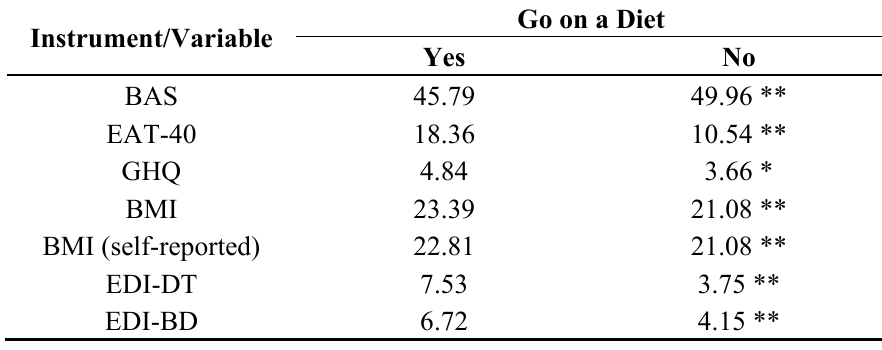
Table 5. Differences between those who went on a diet and those who did